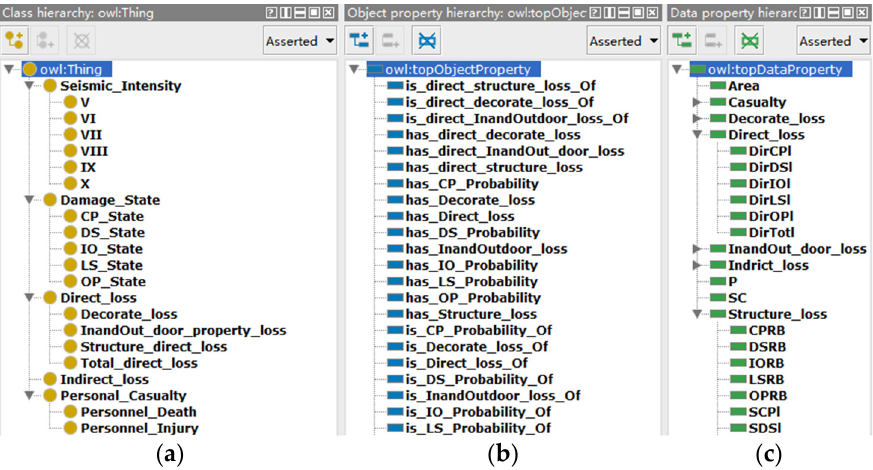
Figure 5. Development of OntoBSRA in Prot é g é -OWL 5.2. ( a ) Classes; ( b ) Object properties; ( c ) Data properties.